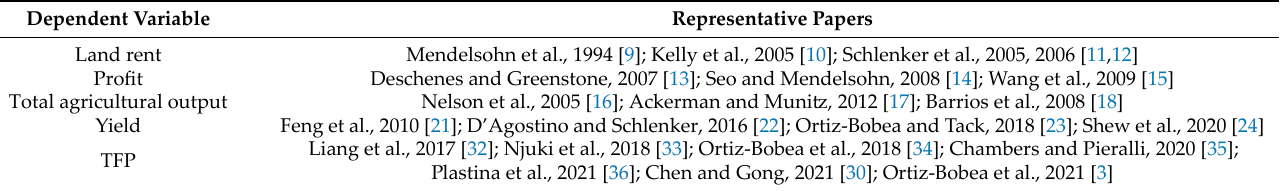
Table 1. Representative papers with various dependent